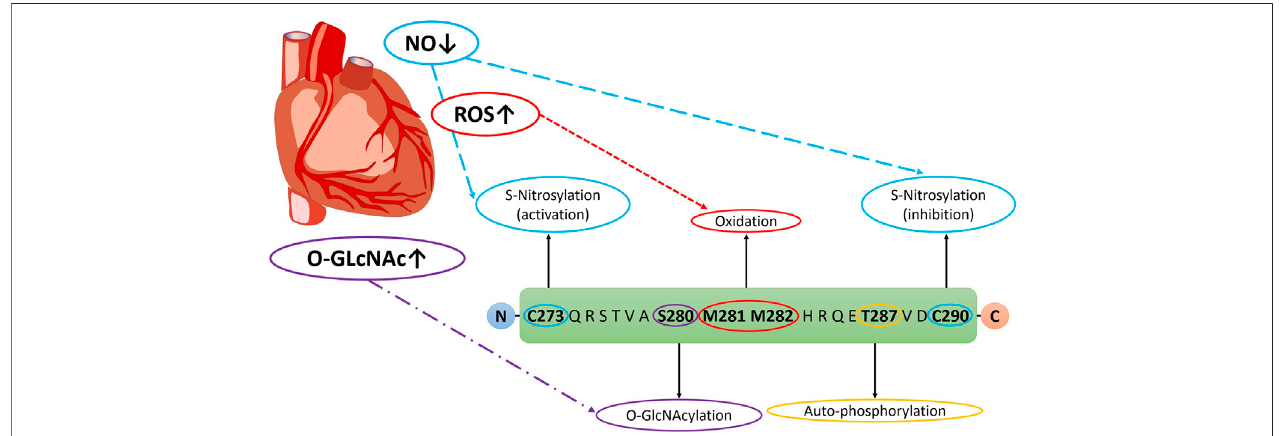
FIGURE 2 | Post-translational modi fi cations on CaMKII Regulatory Domain in DM. Veitch 2021, original